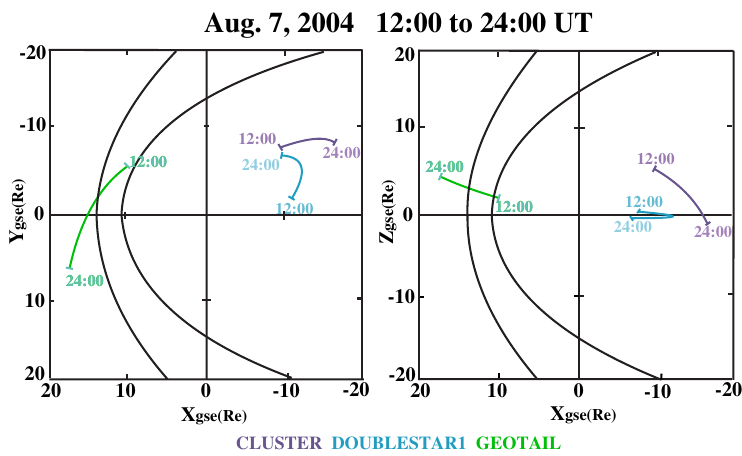
Fig. 1. The trajectories of Cluster, Double Star and Geotail during the period of 12:00 to 24:00 UT on 7 August 2004.